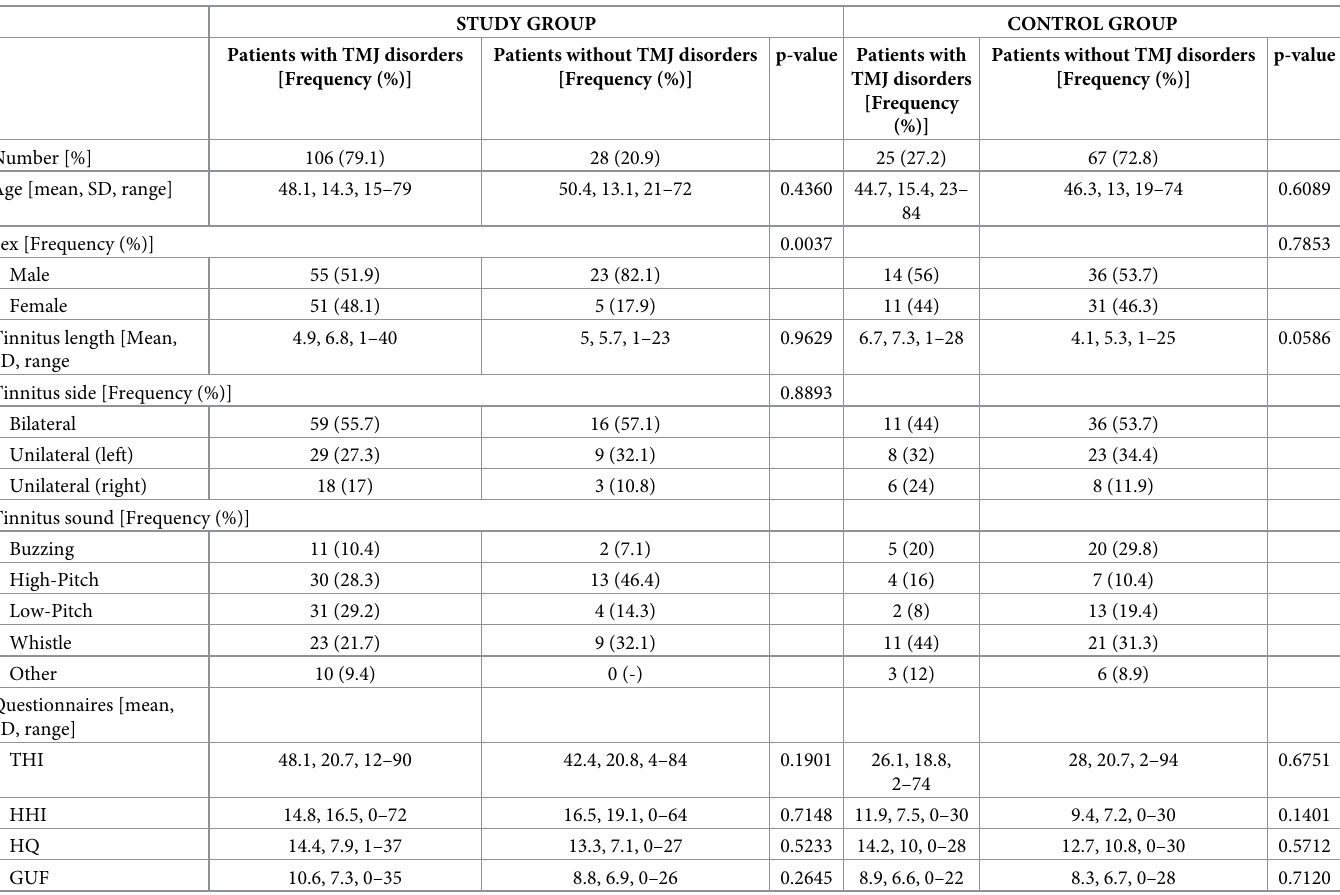
Comparison of demographic and tinnitus characteristics and self-administered questionnaire scores in patients in the study and control groups with and without temporomandibular joint (TMJ)